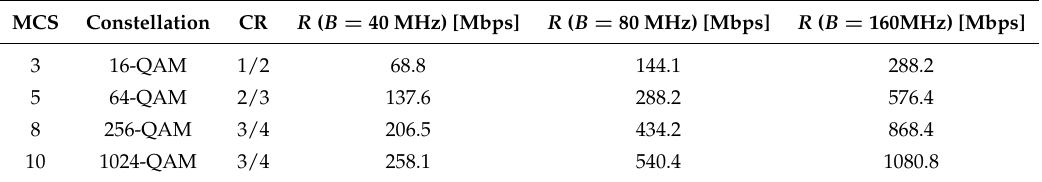
Table 1. Theoretical achievable rates for one SS considering different modulation and coding scheme (MCS) and different values of B